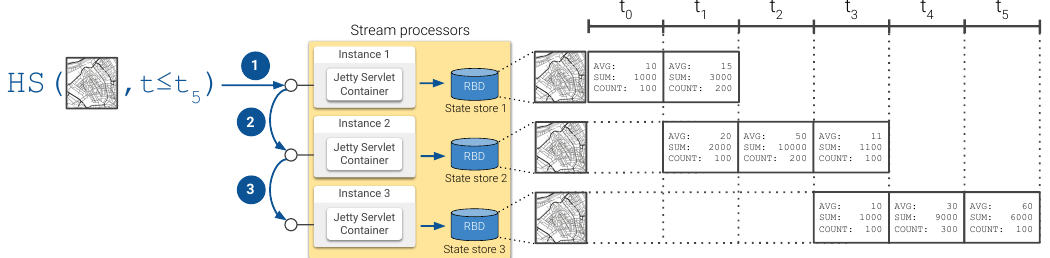
Figure 12. Procedure for distributed query